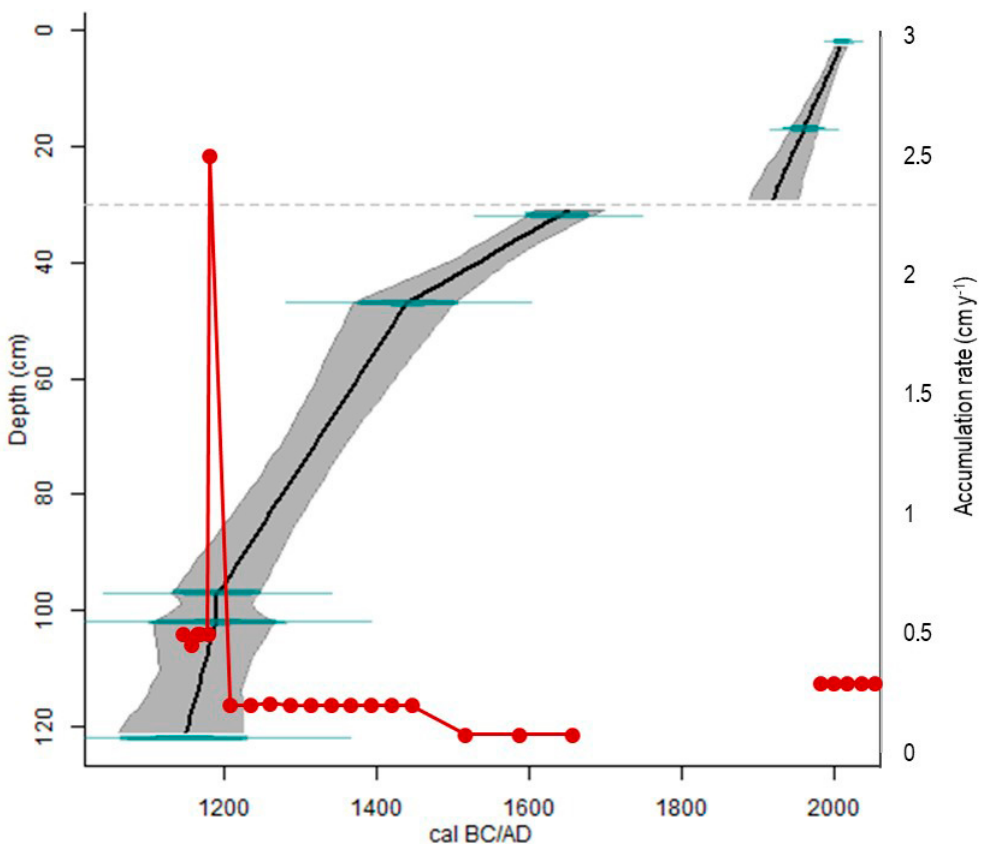
Figure 3. Age depth model obtained from the dates listed in Table 1 using Clam software (Blaauw 2010). The most probable date is depicted in black with the shaded showing the 95% probability interval for each sample. The red line indicates the calculated accumulation rates.